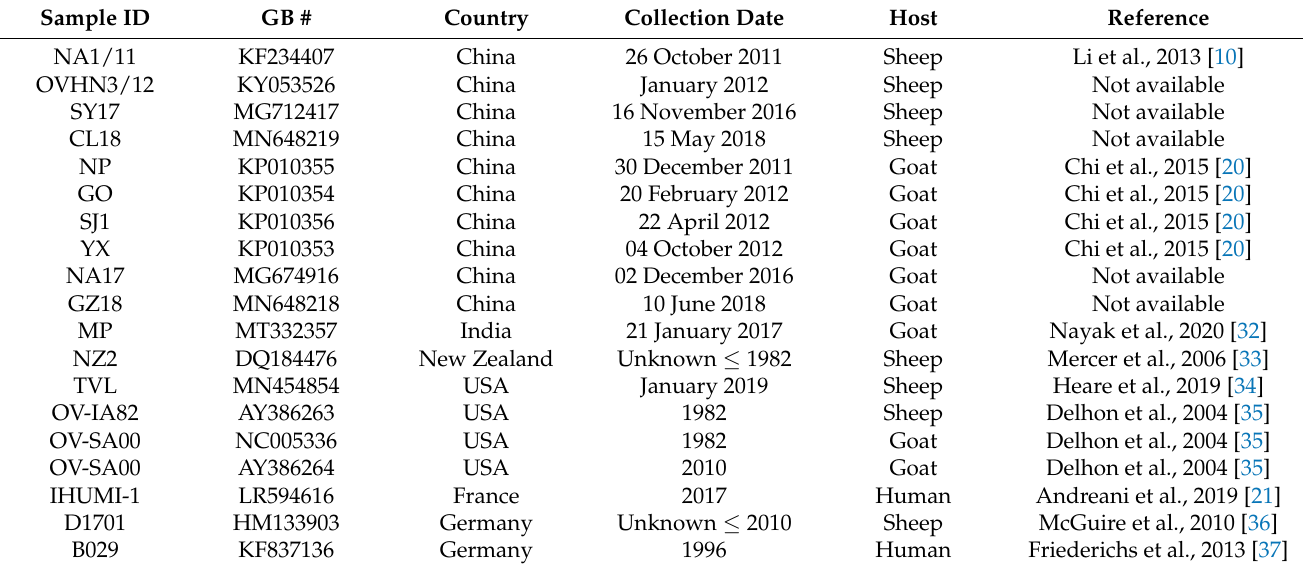
Table 2. Metadata of ORF virus whole genomes already deposited in GenBank and used in the present